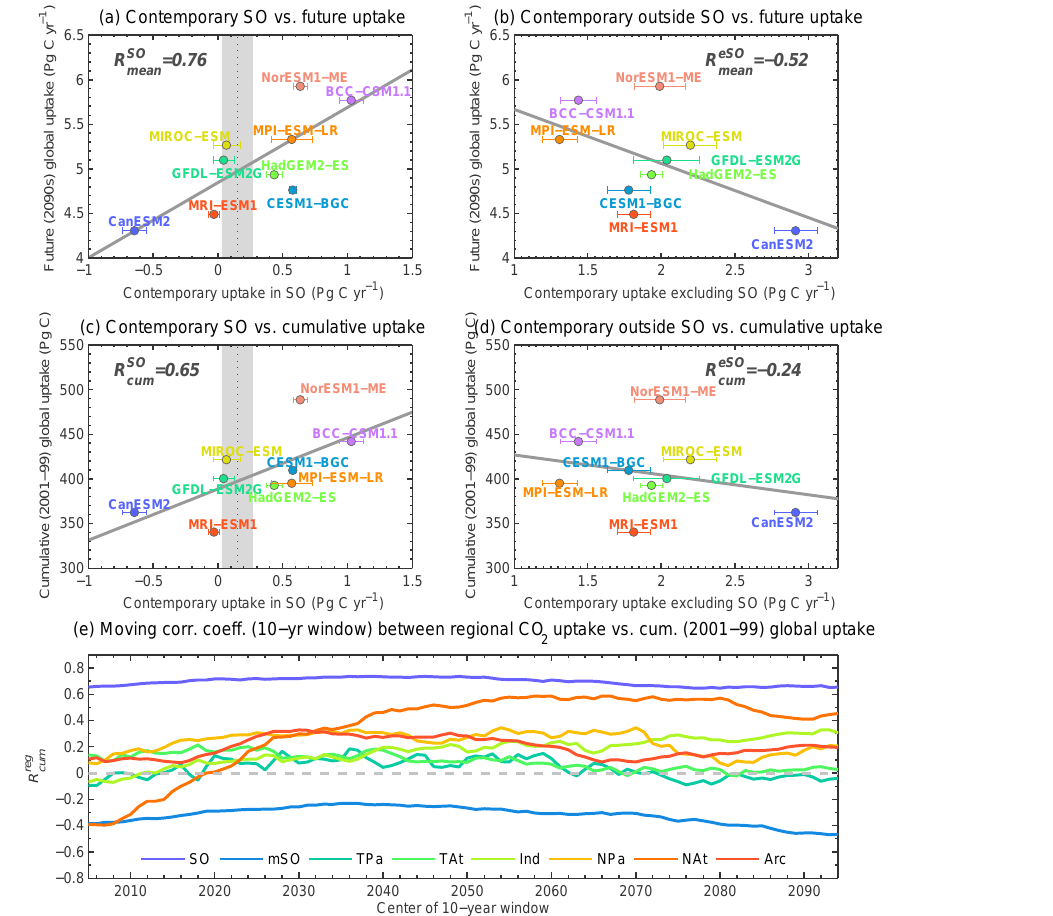
Figure 4. Annual contemporary carbon uptake rate vs. global uptake rate projected for the last decade of the 21st century by CMIP5 models in the (a) high-latitude Southern Ocean (SO) and (b) other ocean regions excluding the Southern Ocean (eSO). Annual contemporary carbon uptake rate vs. cumulative 21st-century carbon uptake projected by CMIP5 models in the (c) SO and (d) eSO. Panel (e) : time series of correlation coefficient computed in a similar way as that in Fig. 3b (blue bars) for every decade between 2001 and 2099. The straight gray lines in panels (a–d) show the best-fit linear regression across all models. Vertical shades on panels (a, c) depict observation-based estimates (Landschützer et al.,